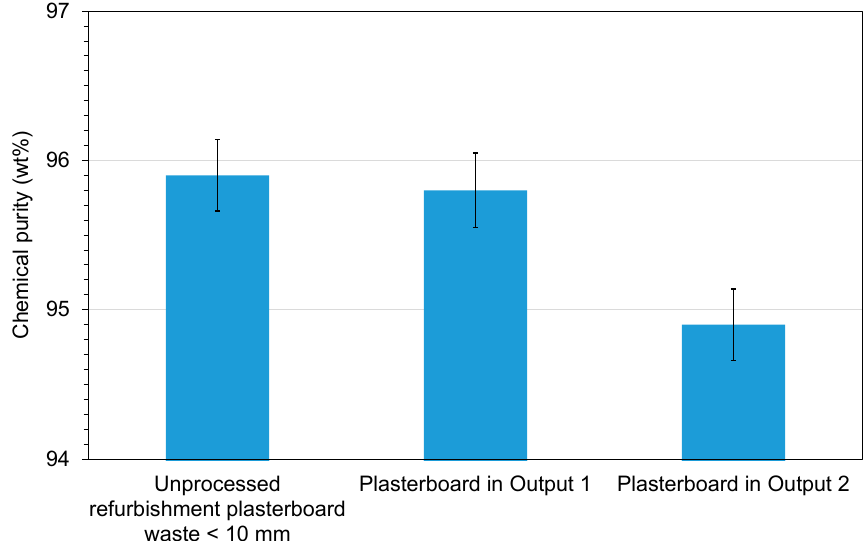
Figure 9. Chemical purity of gypsum obtained from refurbishment plasterboard waste fraction <10 mm in size and from HSI-sorted plasterboard in outputs 1 and 2.